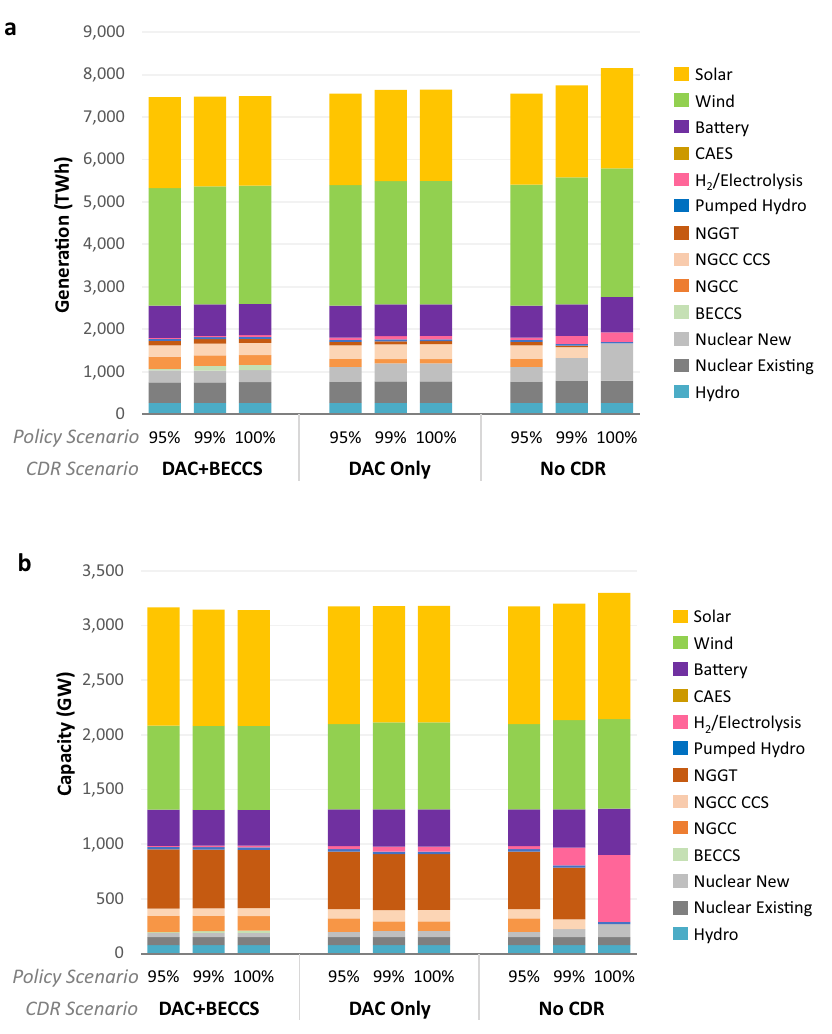
Fig. 3 National electric sector results by technology and scenario. Panels show the impacts of CDR on generation ( a ) and capacity ( b ). Cap refers to the electric sector CO 2 cap policy in terms of percentage reductions relative to 2005 levels. The top panel shows gross discharge from batteries and hydrogen. Scenario assumptions are described in the “ Methods ” section. Results are outputs from the REGEN model 23 detailed in the “ Methods ” section and Supplementary Note 1. Source data are provided as a Source Data fi le.